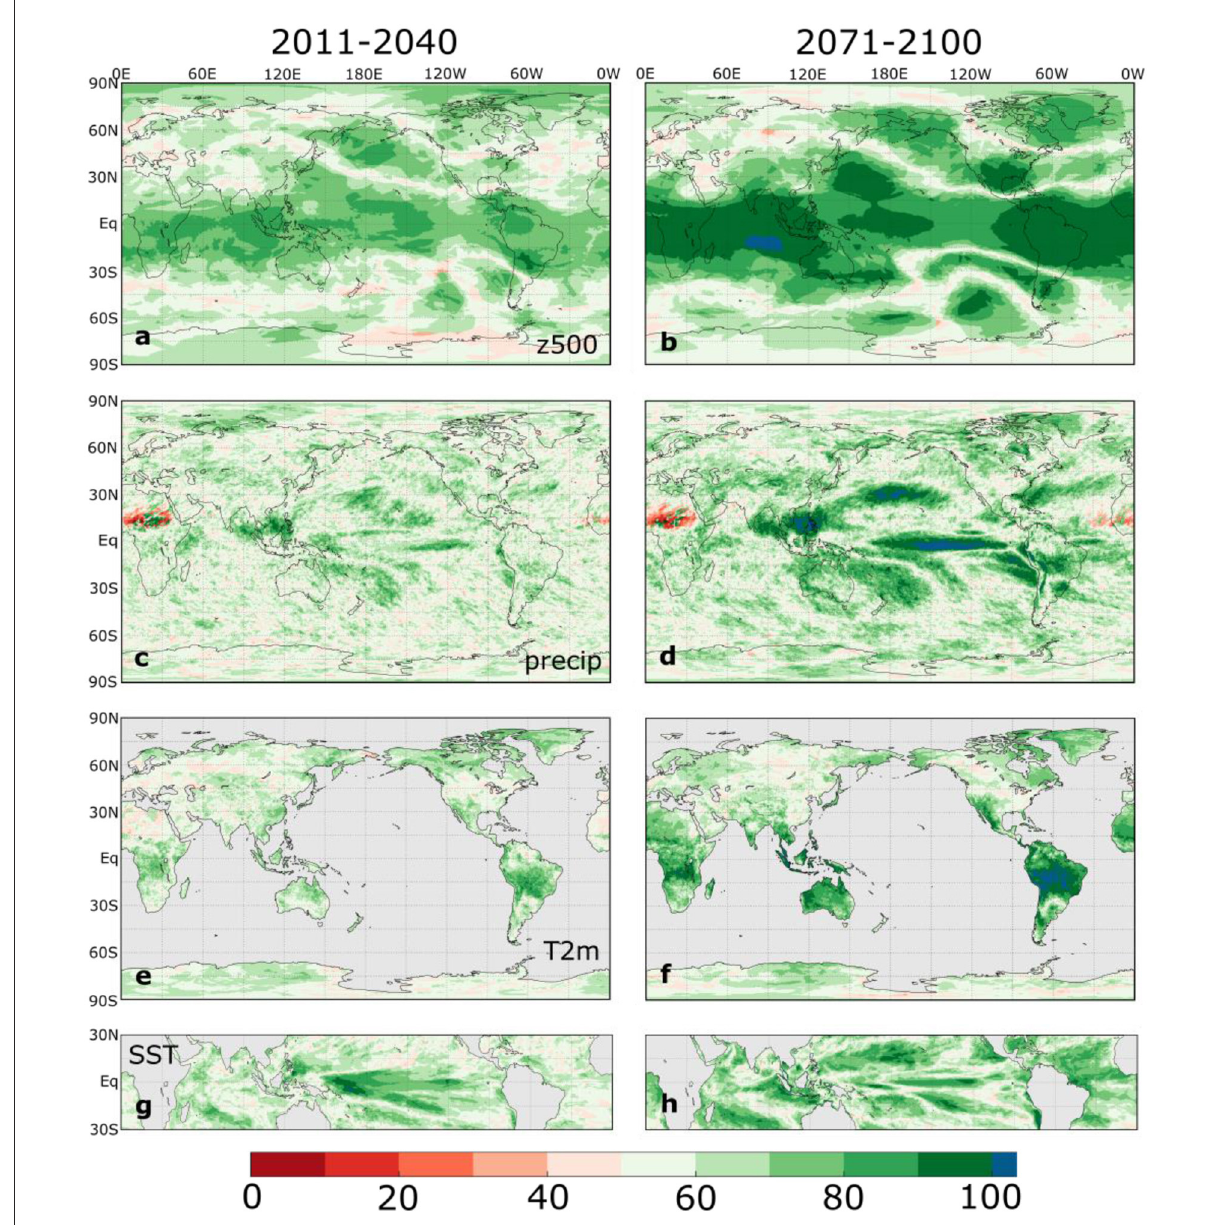
FIGURE6 Percentage of ensemble members that agree on the sign of the ensemble mean SSP5-8.5 SPEAR DJF El Niño composite change relative to 1951–1980 in (left) 2011–2040 and (right) 2071-2100. The rows correspond with (a,b) z500, (c,d) precipitation, (e,f) T2m, and (g,h) SST composite changes. Note that blue shading indicates that all members agree on the sign of the